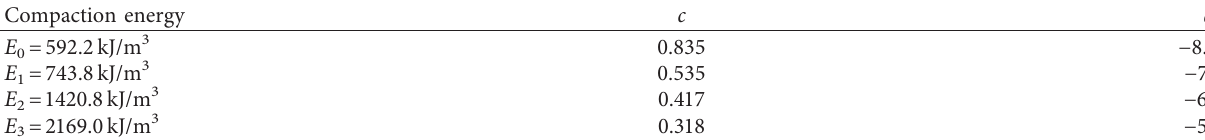
Figure 10: Relationship between intercept b and vertical stress σ . Table 3: Parameters c and d with different compaction energies.